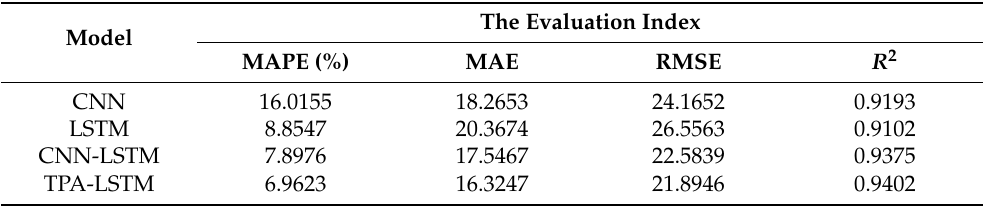
Table 4. Error analysis of prediction results of each model on weekdays and weekends.